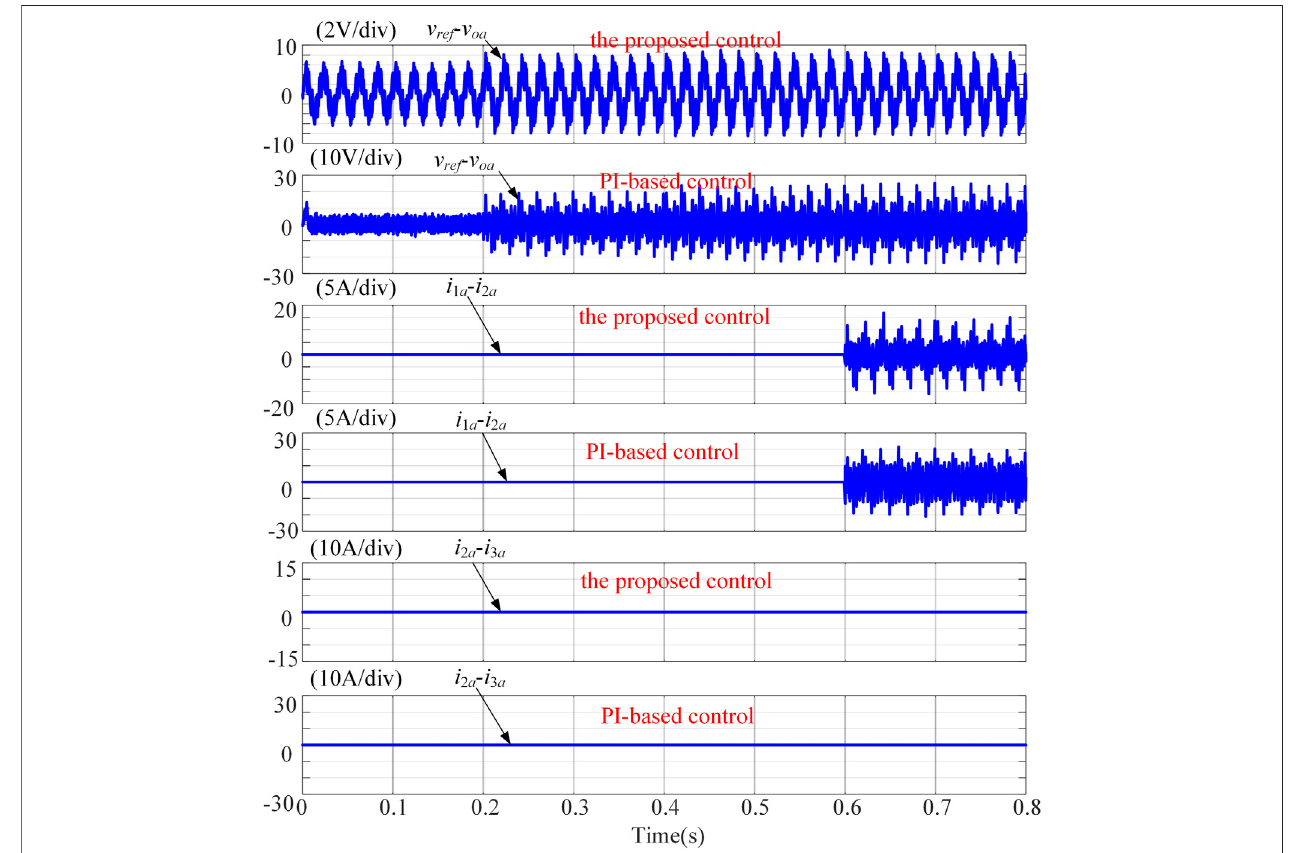
FIGURE 10 | Simulation waveforms of phase-a voltage tracking error and circulating current under nonlinear load condition.